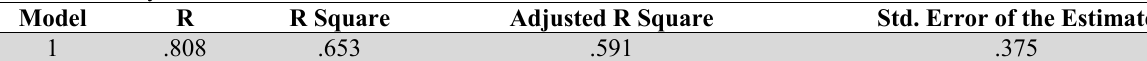
Model Summary – Model 2- ROE Model